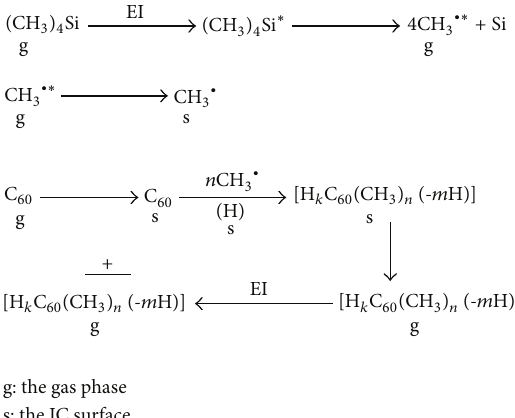
Scheme 1: Homolytic mechanism supposed for the reaction of C 60 with silane 1 under EI in the ionization chamber (IC) of a mass spectrometer. ∗ In an excited